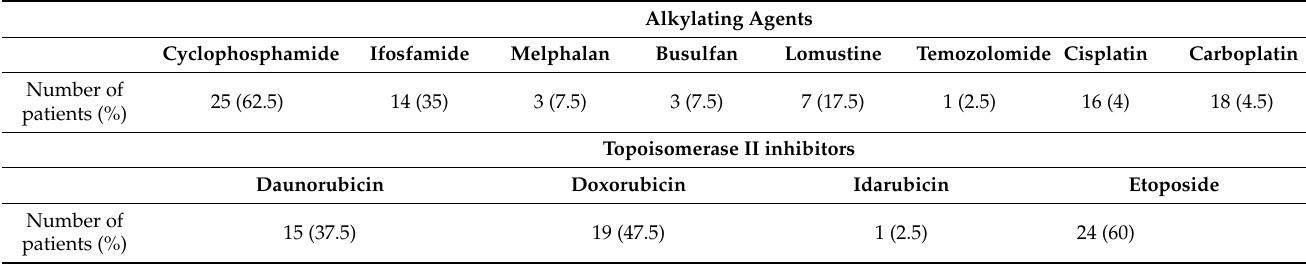
Table 2. Alkylating agents and topoisomerase II inhibitors used in the therapy of the primary